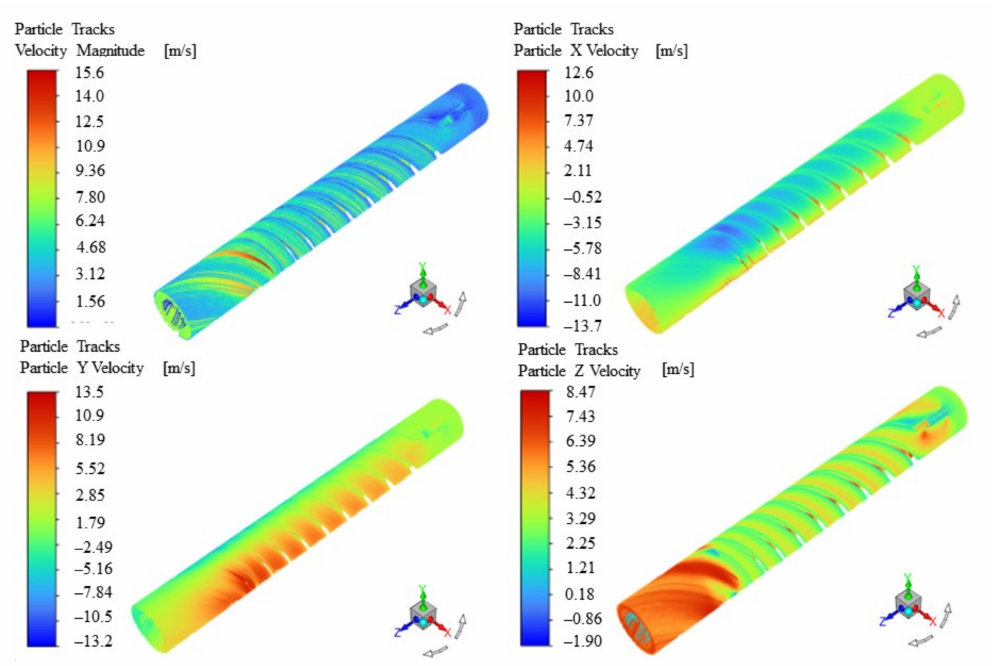
Figure 8. Velocity distribution of sand particles in variable pitch cyclone separator before optimiza-